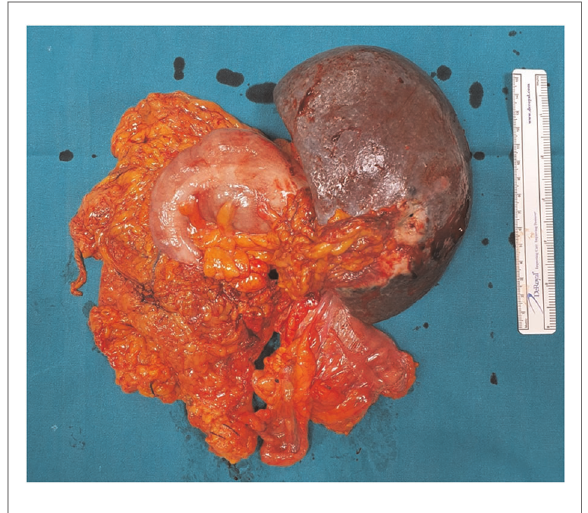
FIGURE 2 Surgical specimens containing splenic fl exure, descending colon, and peripancreatic adipose tissue adhered and in close relationship with the medial surface of the